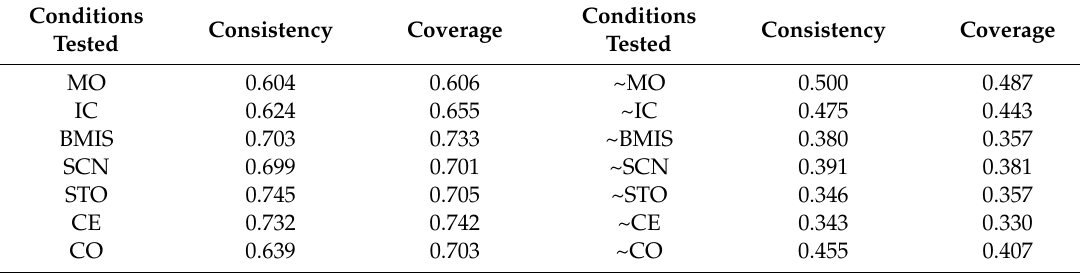
Table 4. FsQCA: Necessary and su ffi cient